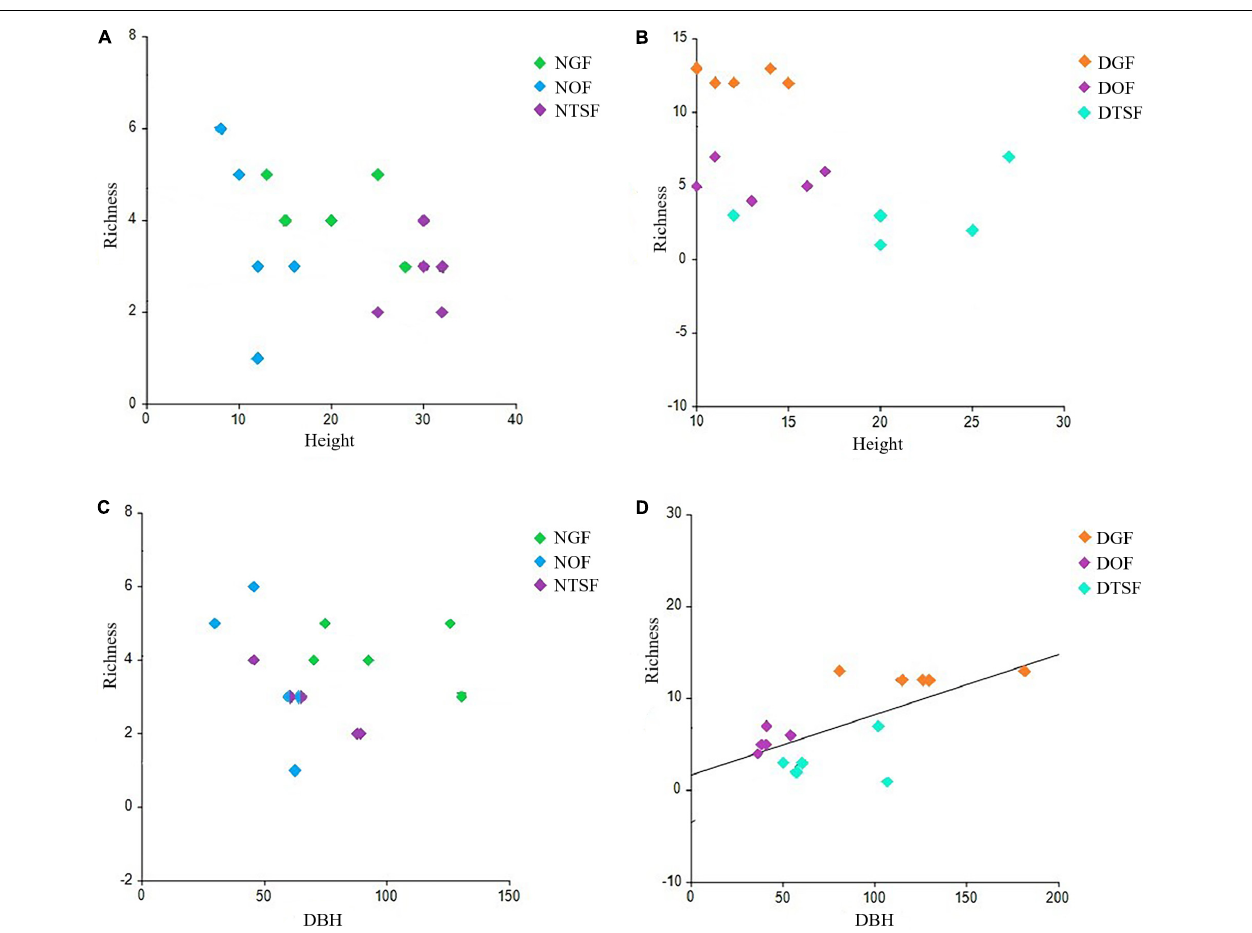
FIGURE 8 | Simple linear regression between phorophyte height and species richness of epiphytic angiosperms in natural sites (A) and disturbed sites (B) . Simple linear regression between phorophyte DBH and species richness of epiphytic angiosperms in natural sites (C) and disturbed sites (D) . NGF = natural gallery forest, DGF = disturbed gallery forest, NOF = natural oak forest, DOF = disturbed oak forest, NTSF = natural tropical sub-deciduous forest, DTSF = disturbed tropical sub-deciduous forest.